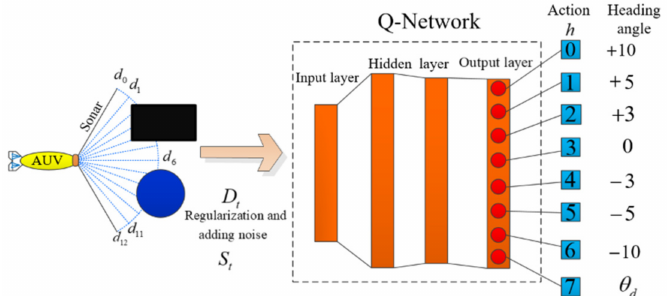
Figure 4. DQN-based AUV collision avoidance